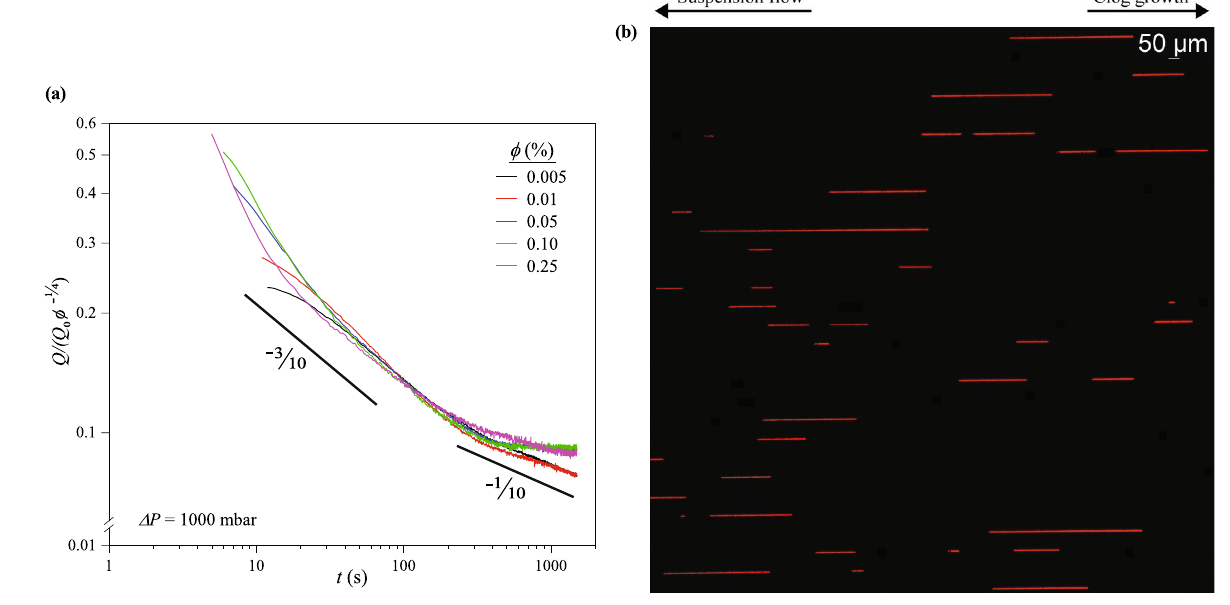
Figure 3. ( a ) Rescaling of flowrate decay curves for t ≥ τ d and all φ when (cid:31) P = 1000 mbar. The flowrate decays collapse into a single master curve in the timescale τ d (cid:31) t (cid:31) τ f , indicating φ only affects the clogging 3 Q ∽ t − 10 . For t (cid:31) τ f , the decay curves do not follow a single scaling: a final plateau is reached for rate and more concentrated suspensions ( φ = 0.05, 0.10 and 0.25%) but a second power-law decay with an exponent (cid:31) of 1 10 is observed for φ = 0.005 and 0.01% , beyond the point of inflection. ( b ) Micrograph of clogged channels showing the discontinuity of clog growth in a system of parallel tapered microchannels. Multiple distinct clogs (fluorescent red streaks or spots) of different lengths are formed in different positions in some of the channels under w c > d p , along l c . The particles form arches across the channels and N c ∽ w c d p . This phenomenon, here regarded as the “discontinuity of clogs”, appears in all the channels, and for all φ and (cid:31) P examined. As demonstrated in Fig. 3a, clogs do not grow from their start points indefinitely. Rather, the formation of clogs upstream truncates the growth of any previously formed clog downstream, and the presence of upstream clogs prevents additional particles from reaching downstream clogs (Fig. 3b). Discontinuous clogs have an effective length that is shorter than if the entire channel was clogged from the start of the first clog to the end of